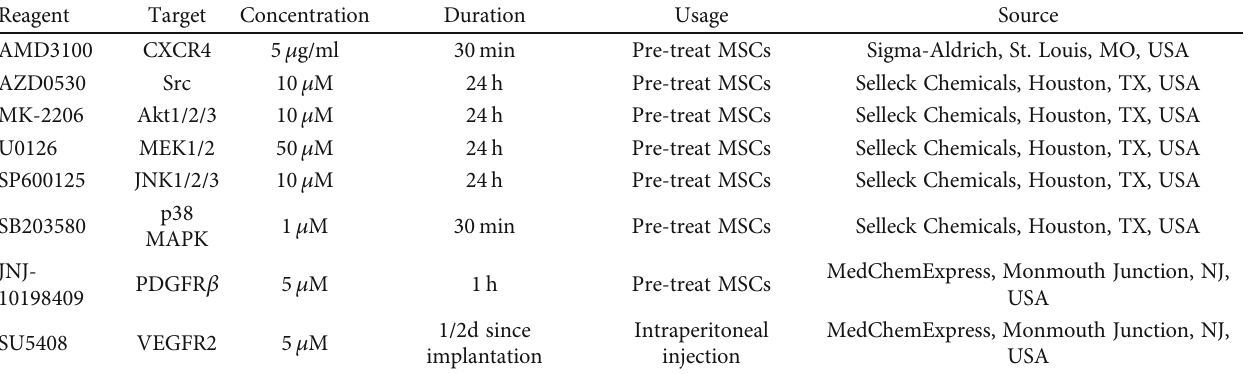
Table 1: Reagent